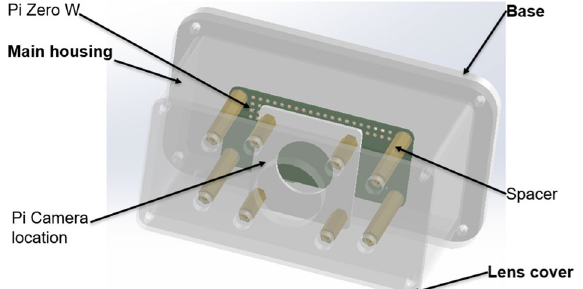
Fig. 3 Labelled CAD model of the camera unit